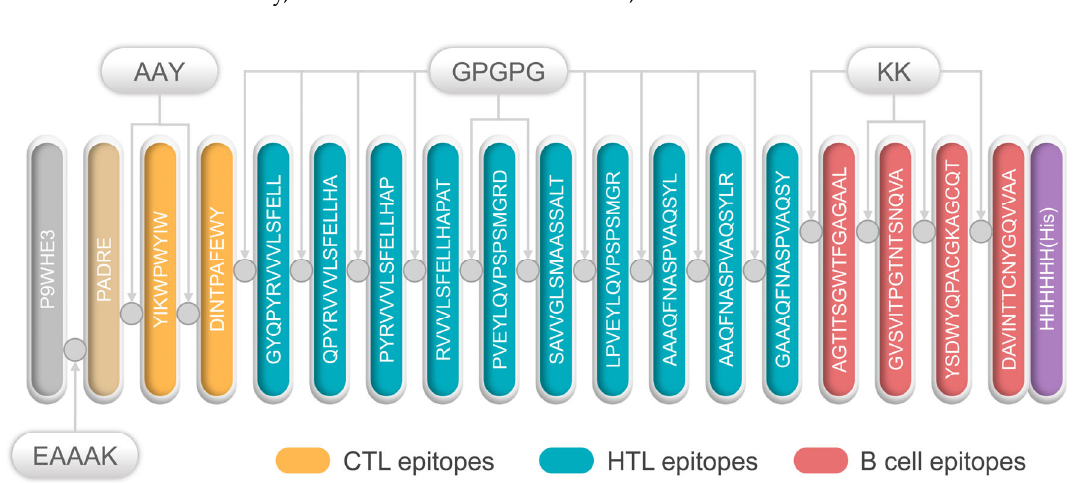
Figure 1. Schematic diagram of the S7D5L4 vaccine. The 454-amino acid peptide sequence contains an adjuvant (light orange) at the amino terminus. It is linked to the pan HLA DR-binding epitope (PADRE) (orange) by the EAAAK linker (indigo blue). The AAY linker is linked to PADRE in a multi-epitope sequence. CTL epitopes (yellow) are ligated using an AAY linker. HTL epitopes (blue) are linked using GPGPG linkers, whereas B-cell epitopes (red) are linked via KK linkers. Finally, a 6x-His tag was inserted into the carboxyl terminus for purification and identification, and the resultant candidate was named, S7D5L4.